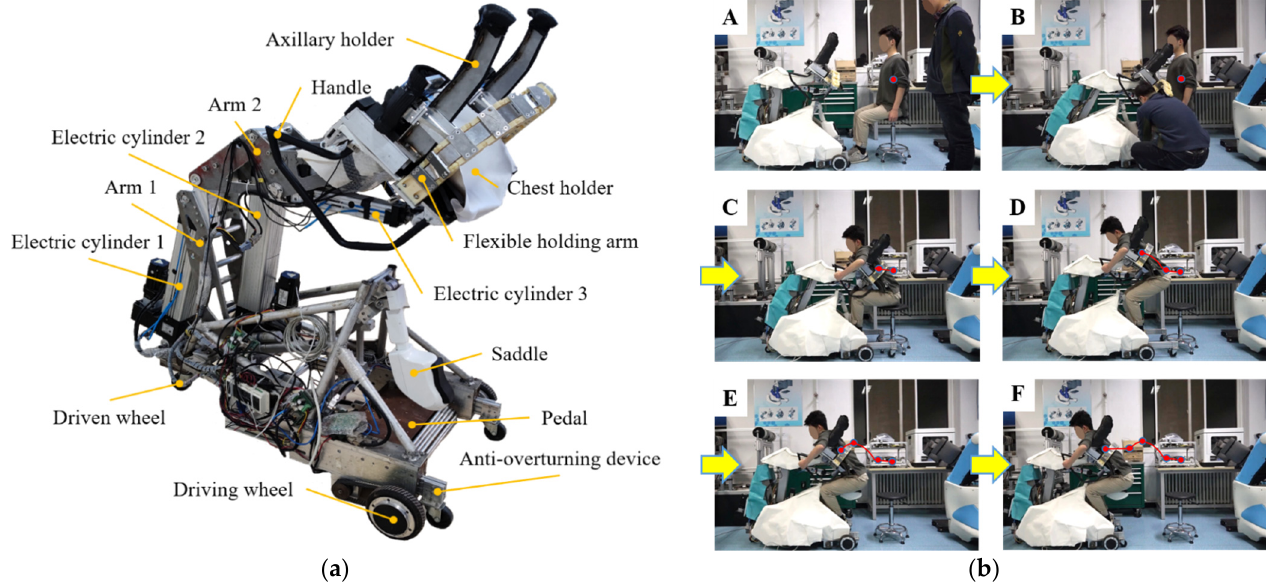
Figure 1. The piggyback nursing-care robot [19]: ( a ) The structure of the robot; ( b ) The transfer process of the robot.